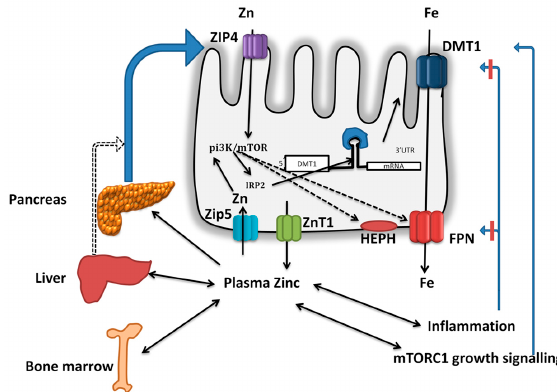
Figure 3. Hypothetical model for direct and indirect e ff ects of zinc on intestinal iron absorption and iron homeostasis: During adequate zinc status and dietary intakes, the biliary-pancreatic zinc secreted into the intestinal lumen stimulates the intestinal iron transport via PI3K-IRP2-DMT1 and FPN1. During inadequate zinc intake, reduced pancreatic zinc levels reduces intestinal iron transporter DMT1 and FPN1 expression, leading to increased retention and inhibition of absorption. Similarly, excretion of zinc from tissues such as liver and bone marrow results in declined tissue zinc, and as a consequence reduced FPN1 expression, leading to reduced secretion for erythropoietic needs. Alternately, zinc might prevent inflammation and thus negate its inhibitory e ff ect on iron absorption. During zinc su ffi ciency, growth signaling mediated by mTORC1 pathway might increase the iron requirements and thus improve iron